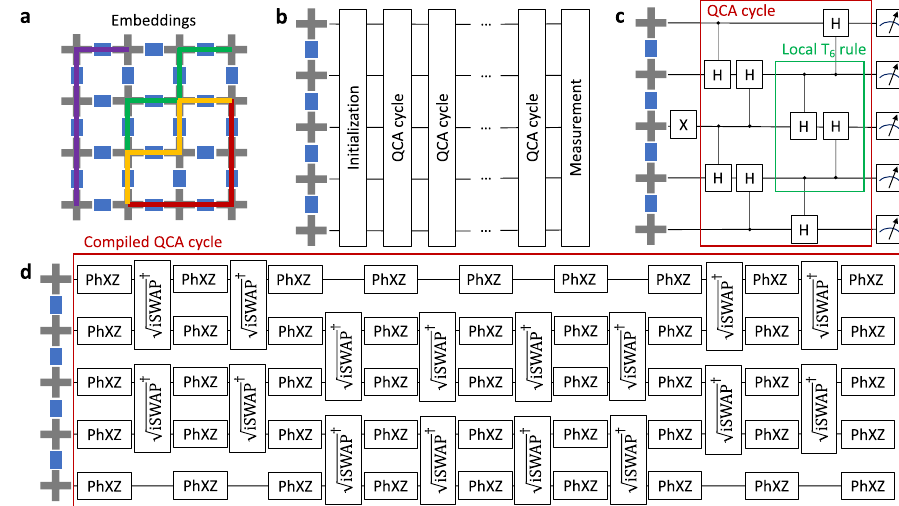
Fig. 1 | One-dimensional quantum cellular automata circuits. a Schematic for embedding one-dimensional chains into a subset of a two-dimensional Sycamore- class quantum processor. Gray crosses represent transmon qubits and blue rec- tangles represent couplers. Purple, green, yellow, and red paths are hypothetical example embeddings. b Generic structure of a one-dimensional quantum cellular automata (QCA) circuit where time fl ows to the right. An initialization step is applied to a chain of L qubits, typically to place them into a classical productstate with some number of bit fl ips ( ∣ 1 i s). A number of unitary QCA update cycles, t , are appliedtoall L qubitsbeforeameasurementisperformed. c Thespeci fi